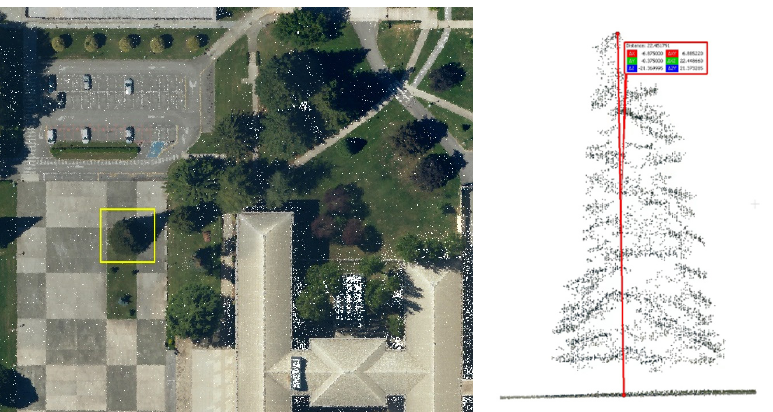
Figure 13. 2017 flight LiDAR point cloud, density: 14 points/m 2 . Isolated vegetation element where the complete section of its mass is observed, as well as level of the ground.